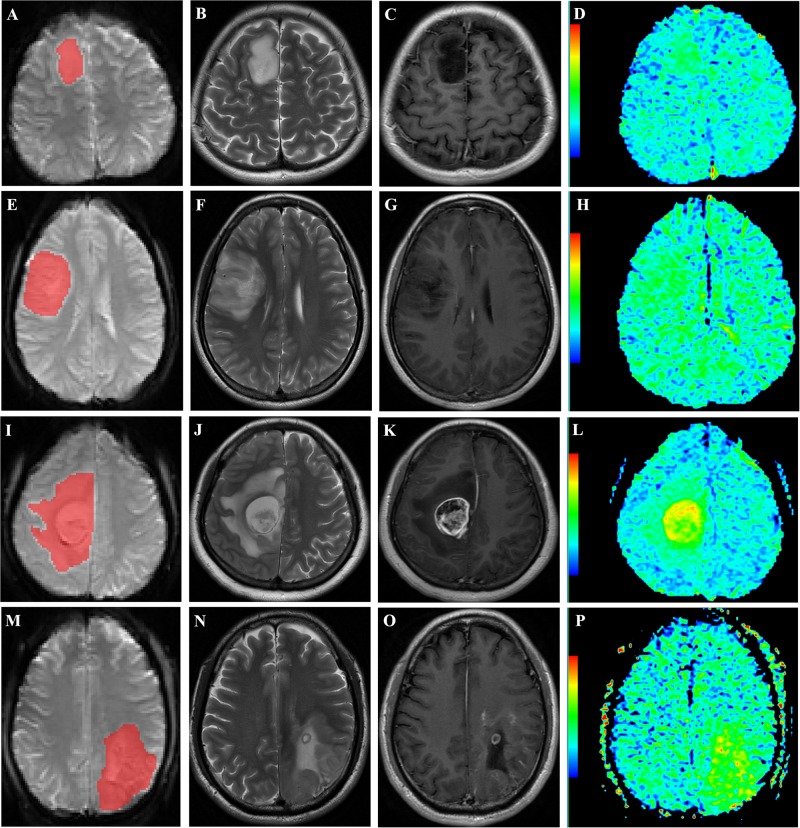
Representative cases. (A–D): a 36-year-old woman with WHO grade II diffuse astrocytoma with IDH1 mutation in the right frontal lobe. ROI selection is based on S0 map of APT raw data (A). The lesion shows hyperintensity on axial T2WI (B) and no enhancement on postcontrast T1WI (C). The APTW image (D) exhibits increased signal intensity in the lesion. E–H: a 31-year-old woman with WHO grade II diffuse astrocytoma with IDH1 wild type in the right frontal lobe. ROI selection is based on S0 map of APT raw data (E). The lesion shows heterogeneous hyperintensity on axial T2WI (F) and no enhancement on postcontrast T1WI (G). The APTW image (H) exhibits increased signal intensity in the lesion. I–L: a 31-year-old woman with anaplastic astrocytoma with IDH1 mutation in the right frontal lobe. ROI selection is based on S0 map of APT raw data (I). The tumor and peritumoral edema shows hyperintensity on axial T2WI (J) and heterogeneous enhancement of tumor on postcontrast T1WI (K). The APTw image (L) exhibits increased signal intensity in the tumor and peritumoral edema. (M–P): a 45-year-old man with anaplastic oligodendroglioma with IDH1 wild type in the left parietal lobe. ROI selection is based on S0 map of APT raw data (M). The tumor shows heterogeneous hyperintensity on axial T2WI (N) and ring-like and strip-like enhancement within tumor on postcontrast T1WI (O). The APTw image (P) exhibits increased signal intensity in the tumor.